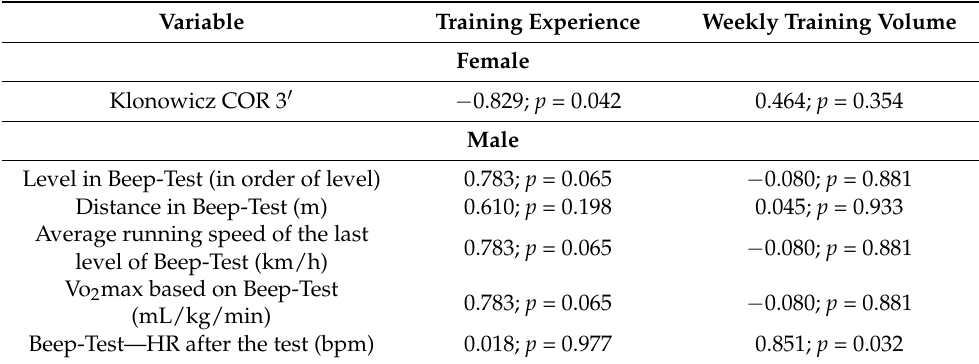
Table 3. Training experience and weekly training volume versus Beep-Test scores and COR of female and male judo cadet (U18) national team athletes using Spearman’s r correlation (only for variables deviating significantly from the normal